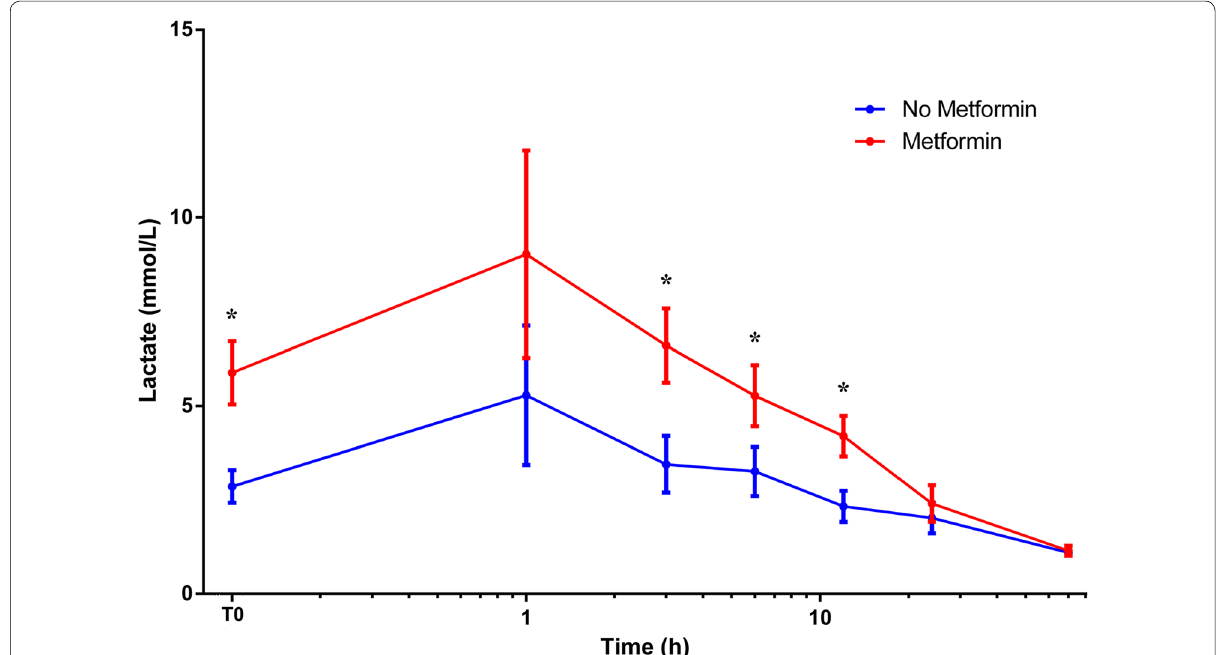
Fig. 1 Initial evolution of lactate level in ICU diabetics sustaining septic shock with or without pre‑admission metformin treatment. T0: time of septic shock diagnosis. Abscissa axis is log 10 scale. * p < 0.05